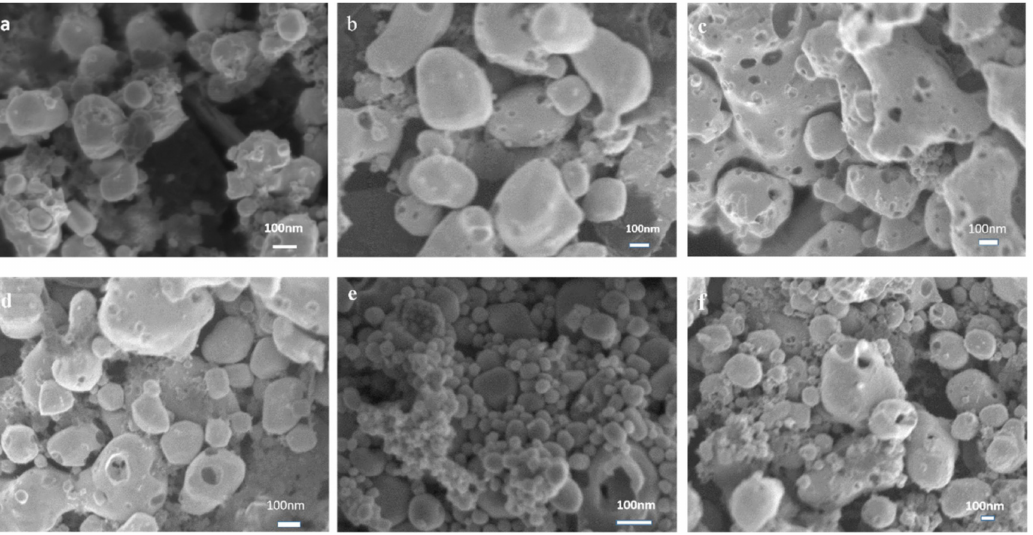
Figure 1. SEM surface images of indium-tin alloy with different ratios: ( a ) 40/60, ( b ) 45/55, ( c ) 50/50, ( d ) 52/48, ( e ) 55/45, ( f ) 60/40. Energy spectrum analysis was done on eutectic composition samples from Figure